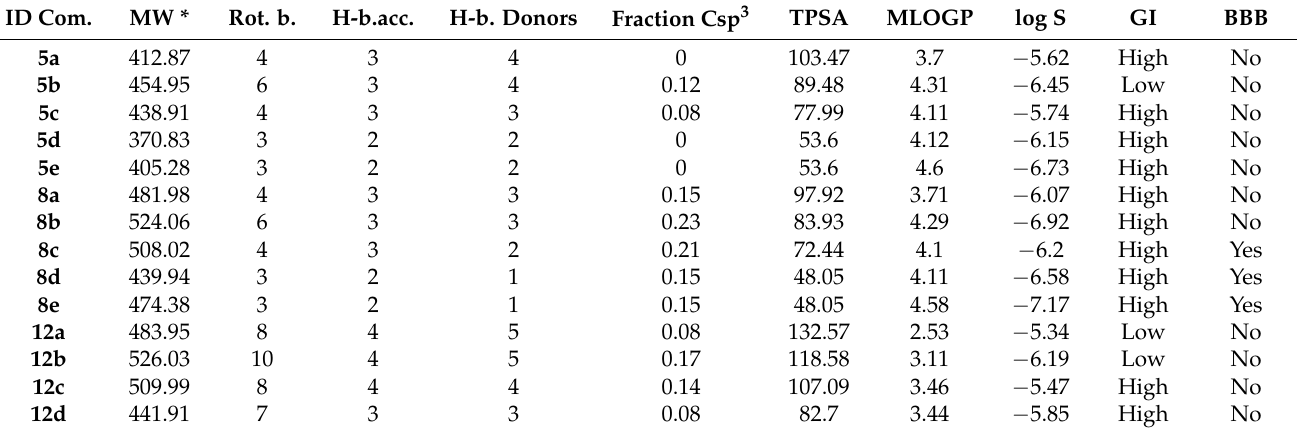
Table 2. ADME properties for 14 7-chloroquinoline-benzimidazole hybrids. ID Com. MW * Rot. b. H-b.acc.